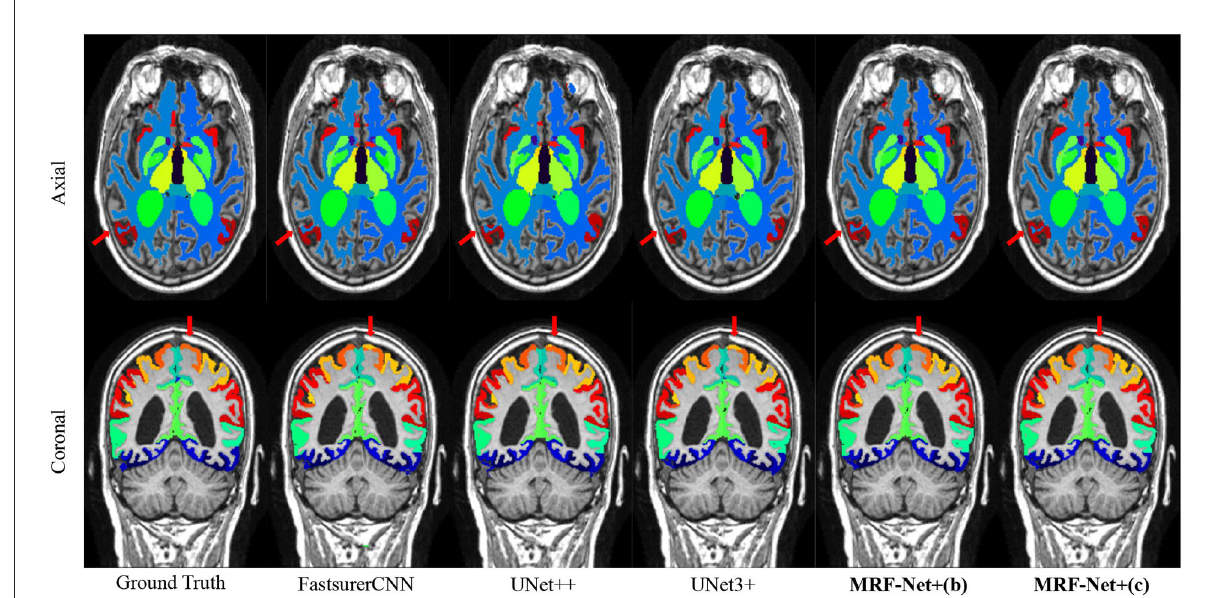
FIGURE3 Segmentation results on the ADNI dataset. The axial plane and coronal plane results are shown, respectively. The red arrow highlights regions where the MRF-Net improved.